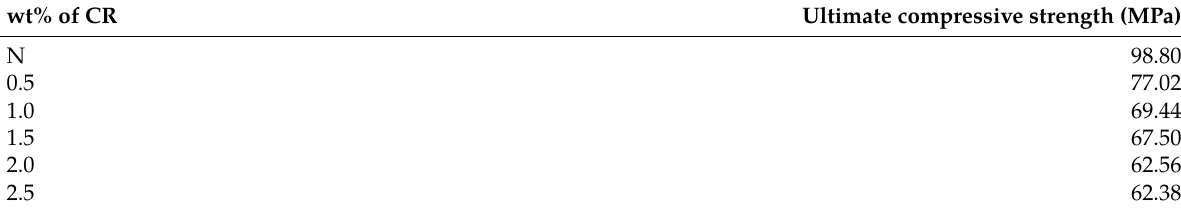
Table 10: Ultimate compressive strength for various CFR compositions. wt% of CR